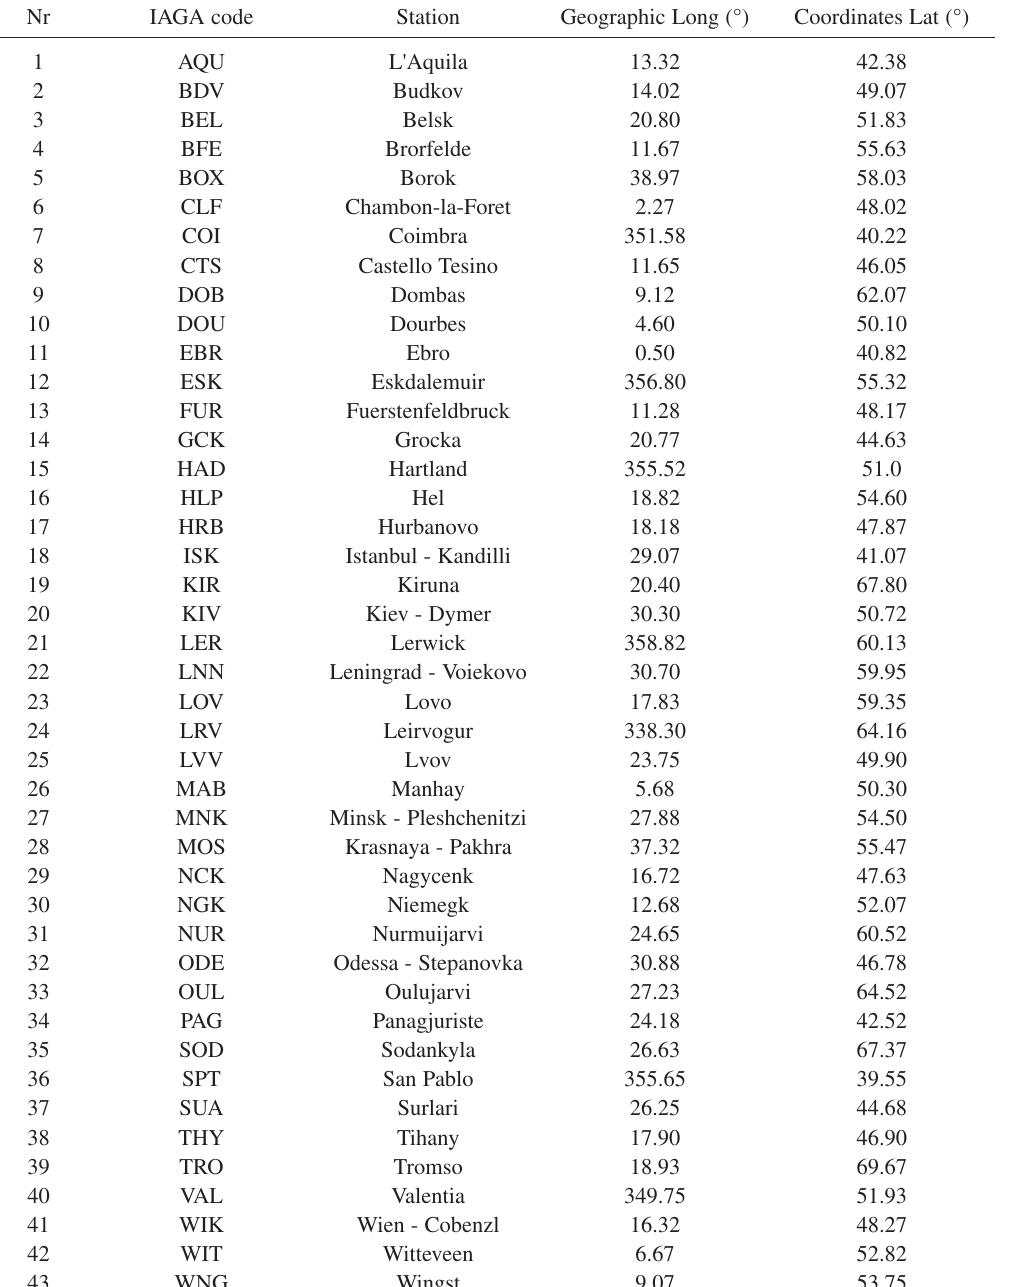
Table I. Geomagnetic observatories considered in the present